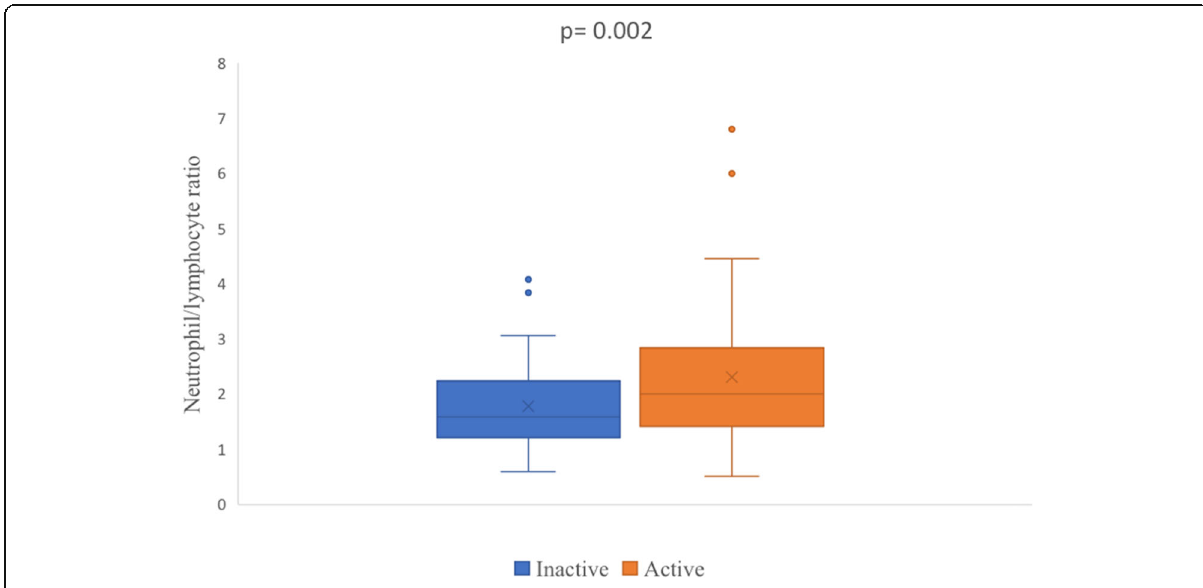
Fig. 1 Mean values of NLR in active and inactive AS patients